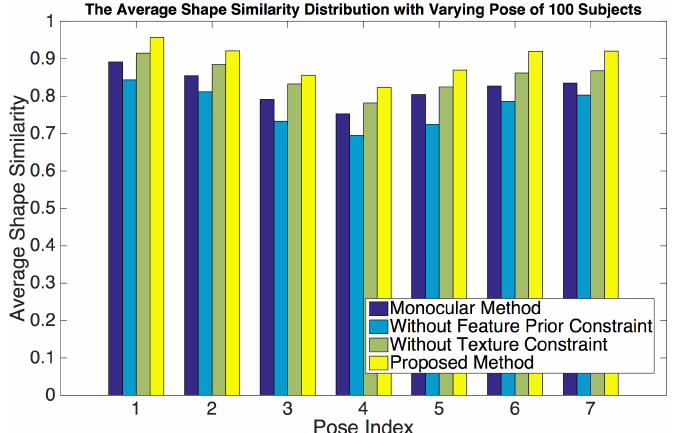
Figure 10. The Average Shape Similarity Distribution with Varying Pose of 100